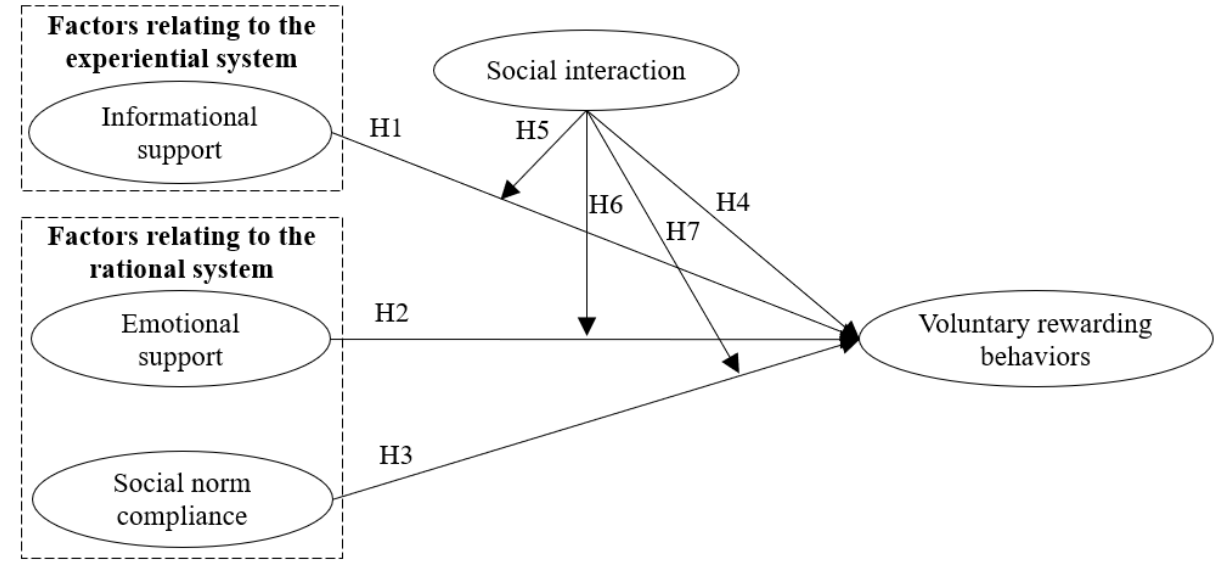
Figure 1. Hypotheses and research